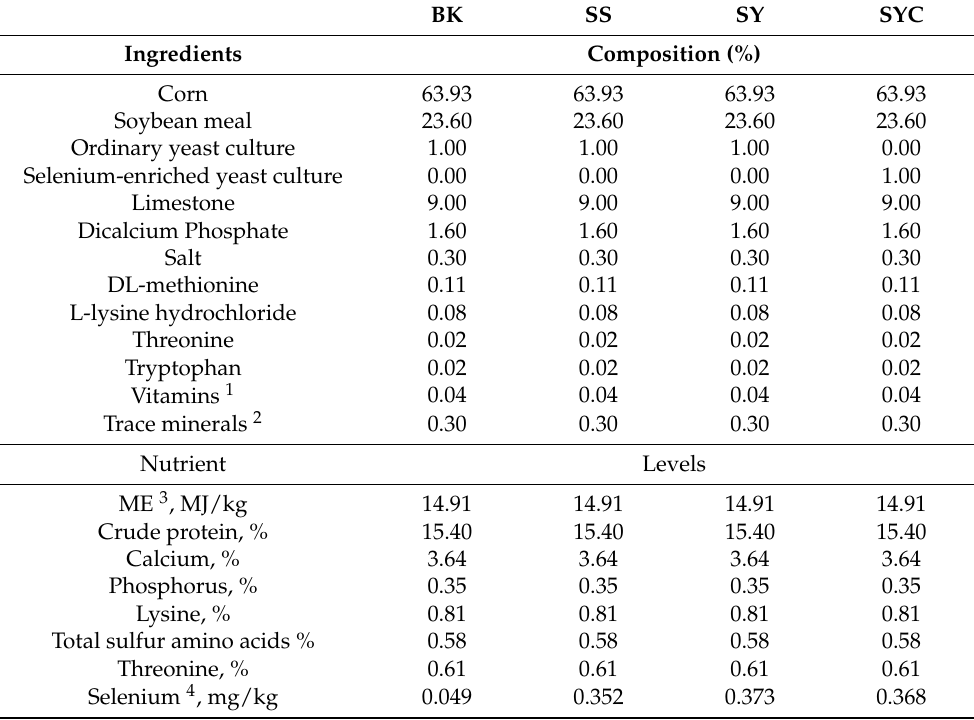
Table 1. Diet composition and nutritional